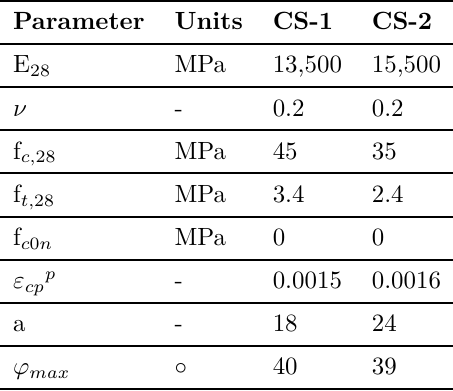
Table 4. Sets of calibrated parameters.